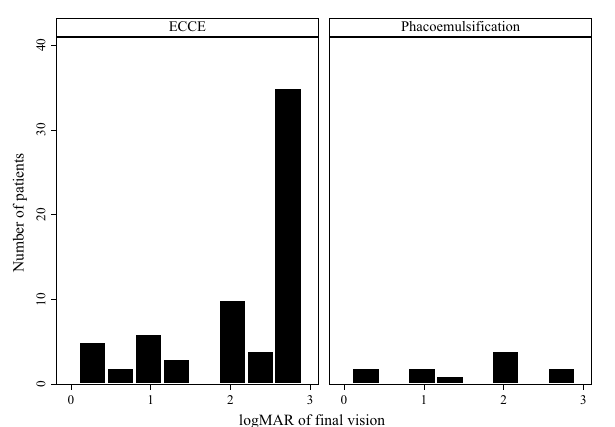
Figure 1. Number of eyes with traumatic cataract wound dehiscence with prior ECCE or phacoemulsification surgery from 2001 to 2015. ECCE extracapsular cataract extraction.